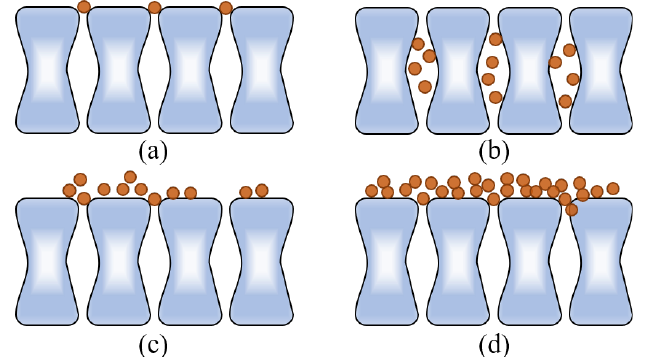
Figure 2. Four types of membrane fouling models. ( a ) Complete blocking, ( b ) standard blocking, ( c ) intermediate blocking, and ( d ) cake filtration. ( c ) intermediate blocking, and ( d ) cake